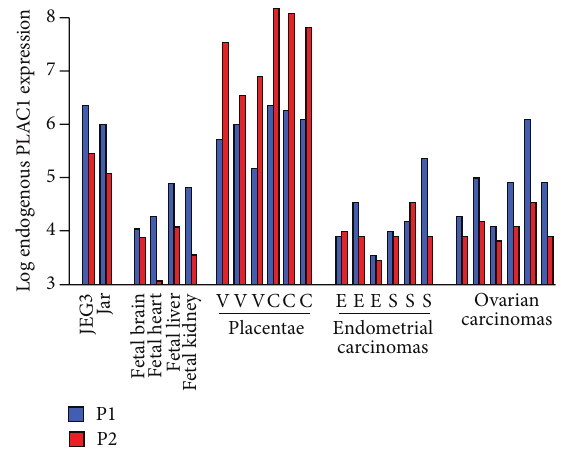
Figure 1: Log 10 PLAC1 expression in all tissues and cells used in this study. Expression is shown by promoter based upon primer pair- specific standard curve regressions. All values are single samples averaged from three technical replicates. In placentae, V is a normal, spontaneous labor vaginal delivery and C is Cesarean section. In the endometrial carcinomas, E is endometrioid adenocarcinoma and S is serous adenocarcinoma. All ovarian tumors are serous